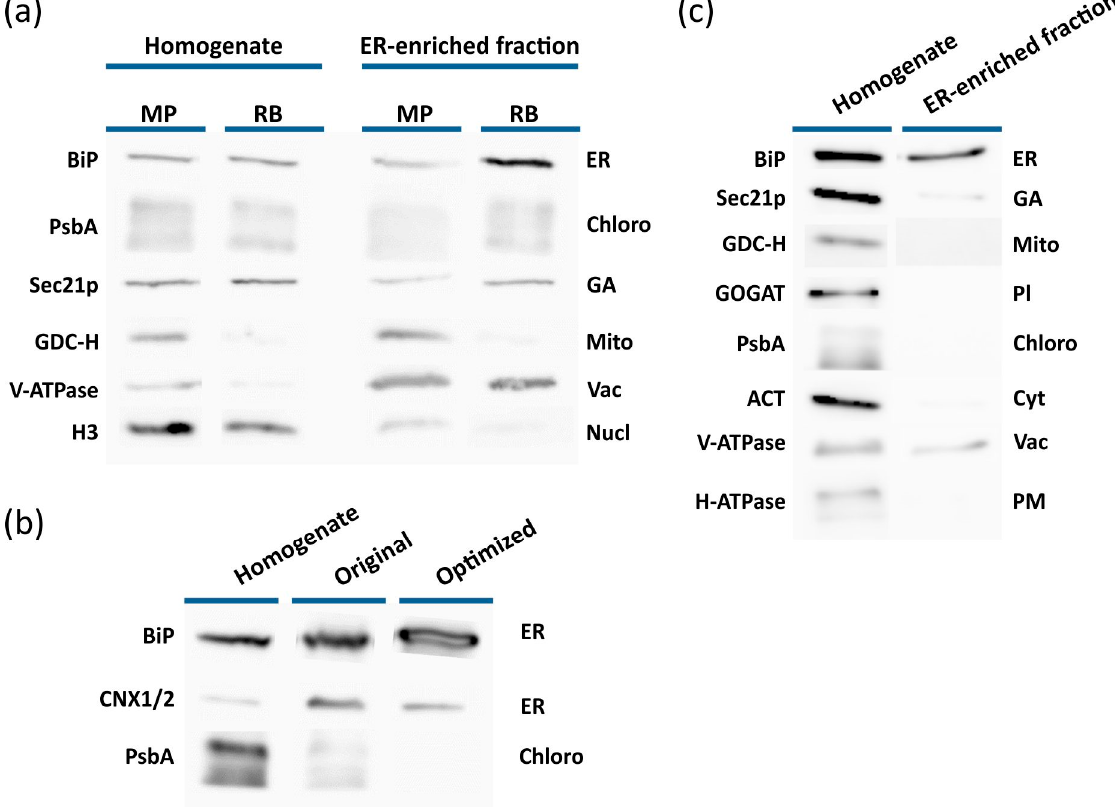
Figure 3. Optimisation of ER isolation from 10-day-old seedlings of A. thaliana . The effectiveness and usefulness of each step in the optimisation process was verified by Western blot analysis. ( a ) Comparison of two homogenisation methods– grinding seedlings using a mortar and pestle (MP) with added quartz sand, and chopping with a razor blade (RB). In both cases, the ER-enriched fraction was isolated using the originally reported sucrose density gradient [6]. ( b ) Organelle profiles of ER-enriched fractions obtained using various density-gradient ultracentrifugation protocols. Organelles were released by chopping seedlings with razor blade. Microsomal fractions were separated using the original or optimised (reduced sucrose density) gradients; for details, see Materials and Methods, Sections 4.5 and 4.6. ( c ) Final evaluation of the ER-enriched fraction obtained using the optimised sucrose density gradient. The following organelle-specific markers were immunodetected: Endoplasmic reticulum–ER (Lumena-binding protein, BiP and Calnexin homolog 1/2, CNX1/2), nuclei–Nucl (Histone 3, H3), Golgi apparatus–GA (Coatomer subunit gamma, Sec21p) vacuoles–Vac (Epsilon subunit of tonoplast H+ATPase, V-ATPase), chloroplasts–Chloro (D1 protein of photosystem II, PsbA), plastids–Pl (Glutamine oxoglutarate aminotransferase, GOGAT), mitochondria–Mito (H protein of glycine decarboxylase complex, GDC-H), cytosol–Cyt (actin, ACT), and plasma membrane–PM (plasma membrane H+ATPase,